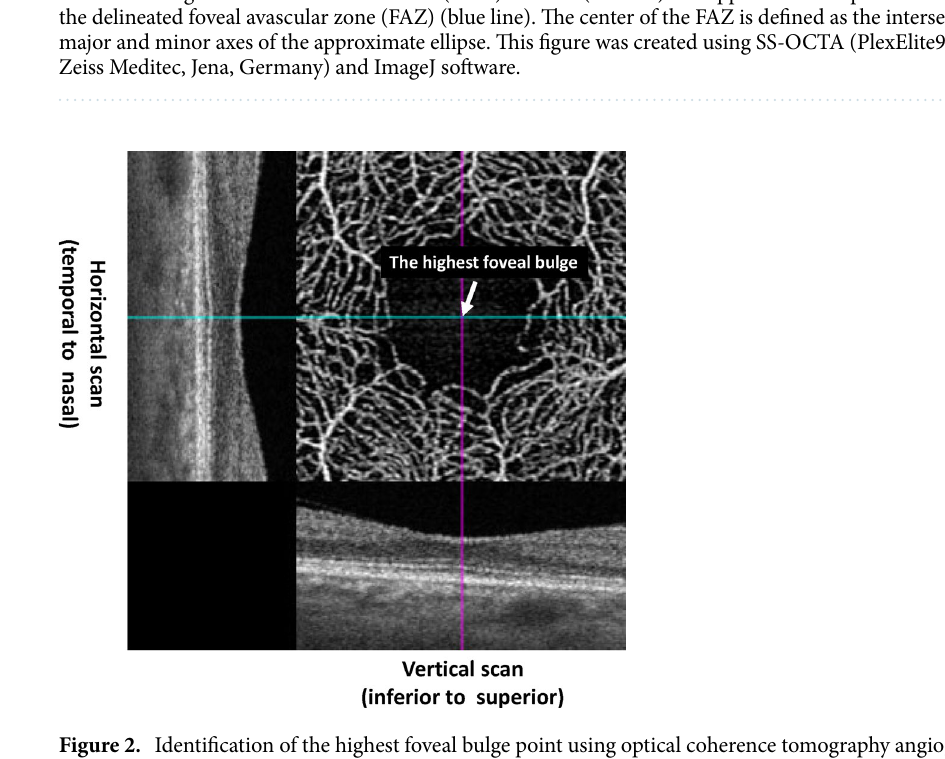
Figure 2. Identification of the highest foveal bulge point using optical coherence tomography angiography. The intersection of the highest foveal bulge (FB) in the horizontal and vertical scans was defined as the highest FB point. This figure was created using SS-OCTA (PlexElite9000 Carl Zeiss Meditec, Jena, Germany) and ImageJ